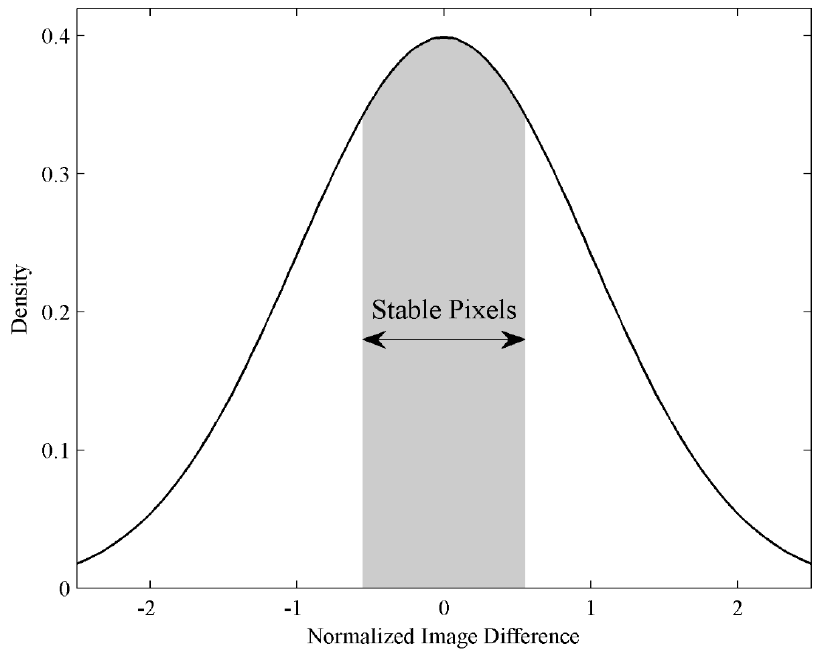
Figure 1. Identification of stable pixels based on image difference histograms (I 2 − I 1 ) for each land cover class. Stable pixels are those within a given distance from the mean ( µ k ) of class k .